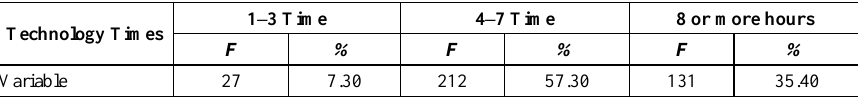
Table 2. Distribution of academicians regarding technology time used in lesson preparation